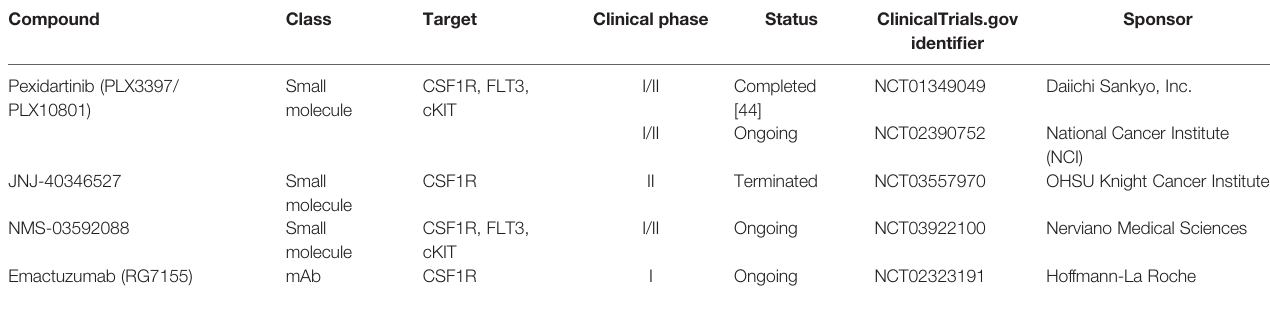
TABLE 1 | Summary of CSF1R targeted therapies for leukemias in clinical trials (2020).